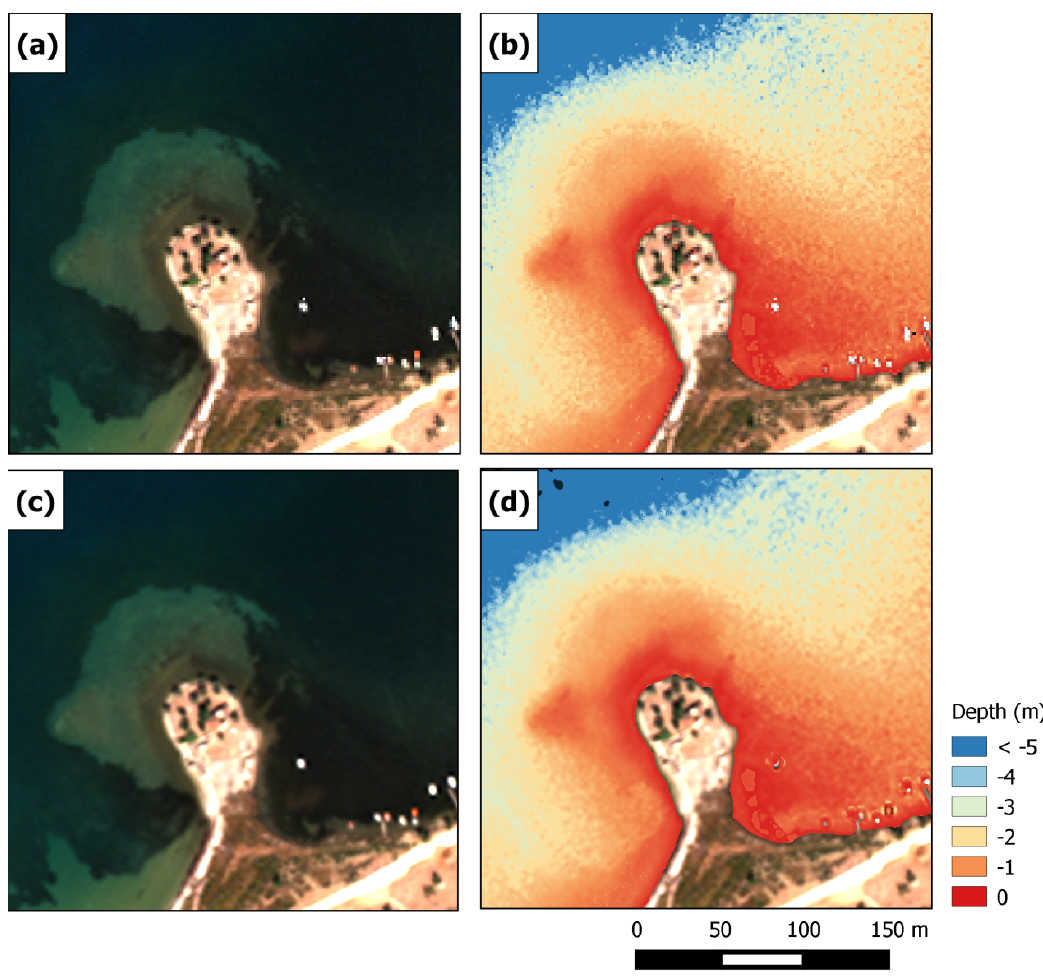
Figure 13: True color composite WorldView 2 images (left column) and HOPE derived bathymetry maps (right column) of the area surrounding the Metohi peninsula. (a) and (b) – image taken on 19.09.2013 at 1.6m spatial resolution; (c) and (d) – pan- sharpened image taken on 19.09.2013 at 0.4 m spatial resolution.